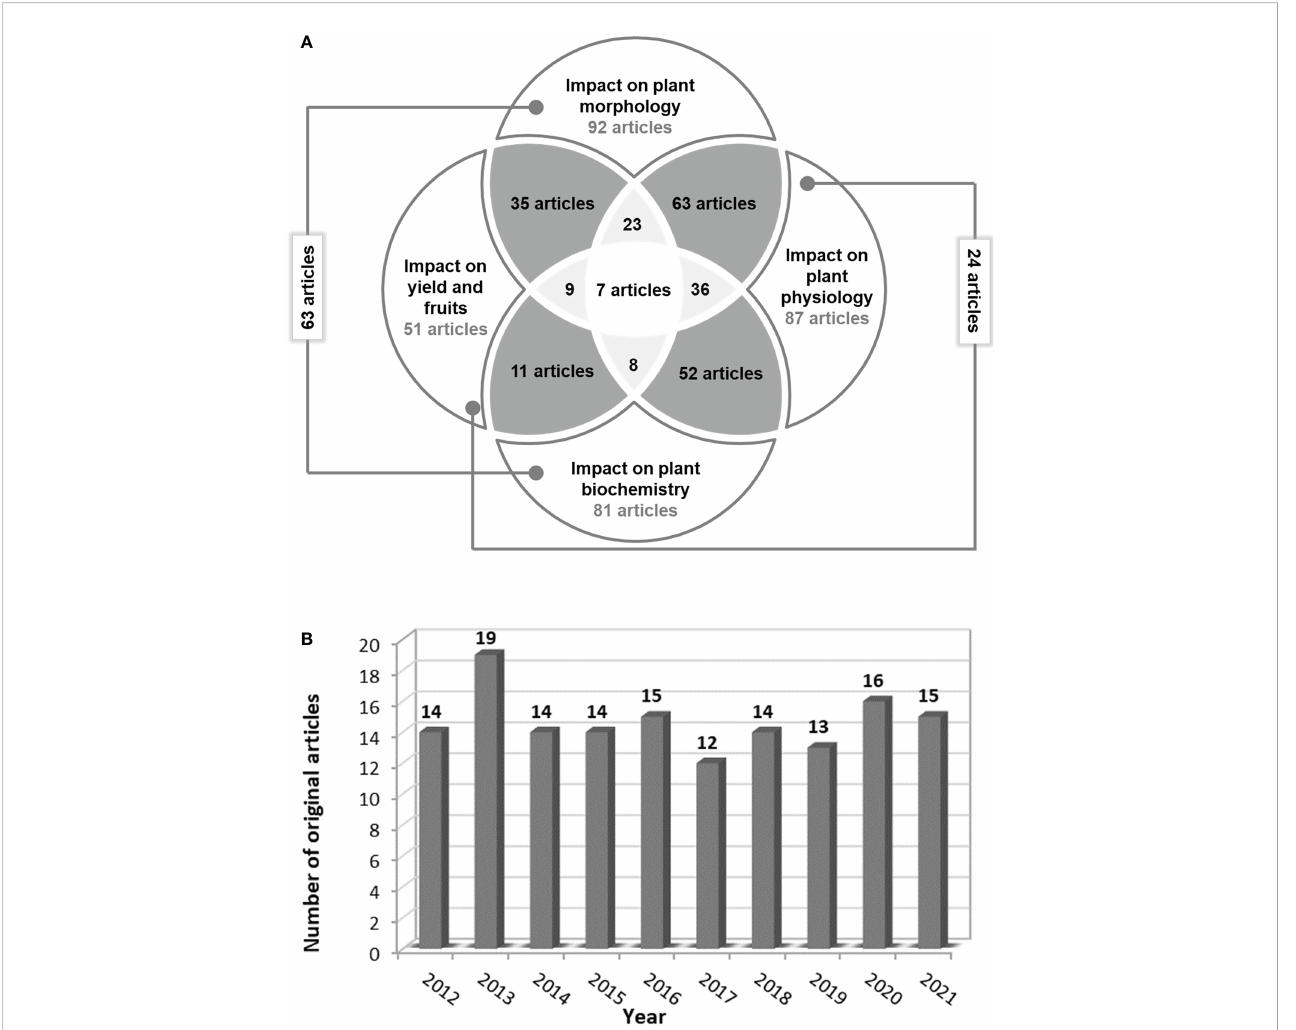
FIGURE 4 The number of relevant articles (A) which underline the salinity impact on tomato morphology, physiology, biochemistry or/and yield and fruits and (B) published annually starting from